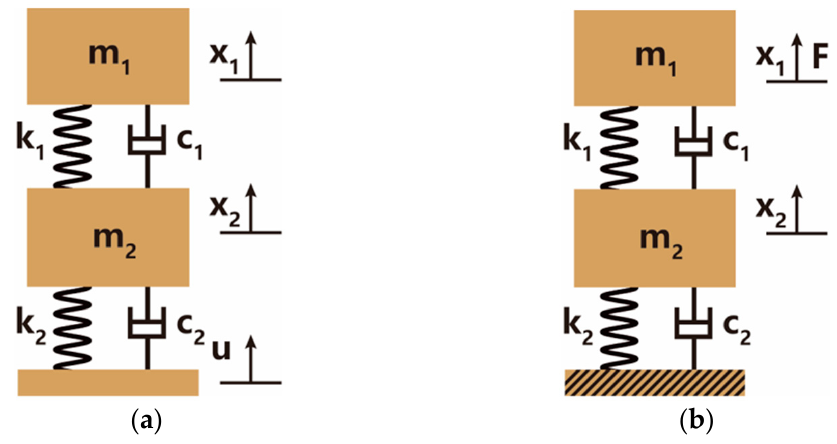
Figure 6. The equivalent model of the TSSS: ( a ) the acceleration transmissibility model; ( b ) the acceleration response model. The parameters k 1 and c 1 are the equivalent stiffness and damping coefficient of the inner suspension along the exciting direction, while k 2 and c 2 are those of the outer suspension. Other parameters are defined as follows: m 1 and x 1 are the mass and displacement of the FOVH, m 2 and x 2 are the mass and displacement of the middle frame, u is the displacement of the outer frame. In the acceleration transmissibility model, 𝐹 is the ambient exciting force provided by the signal in the acceleration response model.